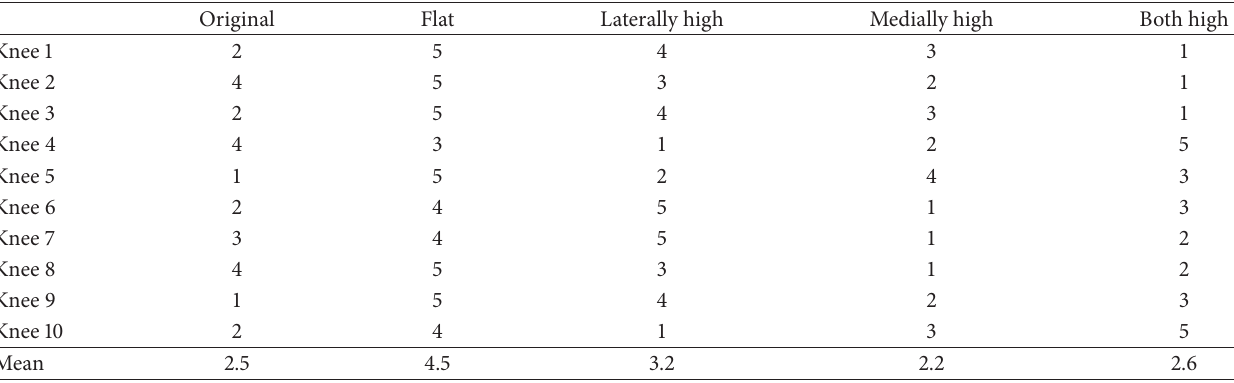
Table 1: Sequence of the five designs for observing maximum pressures for all ten measured knee specimens. Data is averaged over the flexion range of 15 ∘ –50 ∘ , scaling ranges from 1 = lowest pressure to 5 = greatest pressure. The major interindividual differences as well as the poor performance of the flat design are clearly